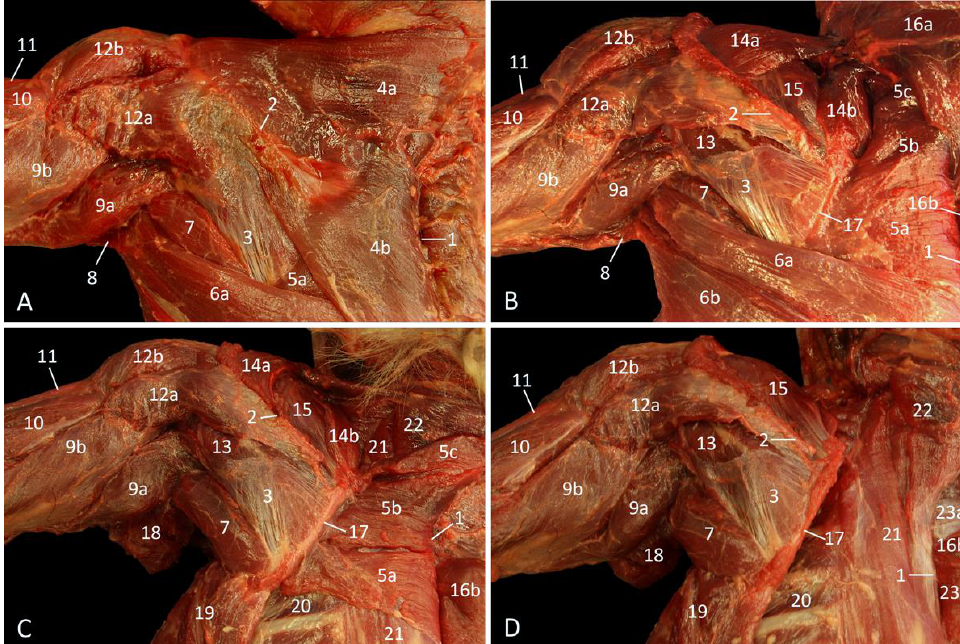
Figure 3. Dorsal view of the left shoulder. ( A ): Superficial layer, ( B ): Second layer, after the m. trapezius has been retracted, ( C ): Deep layer, after removing the m. latissimus dorsi, the m. tensor fasciae antebrachii and the m. trapezius pars cervicalis, ( D ): Deepest layer, after retracting the m. rhomboideus, and the mm. atlantoscapularis cranialis et caudalis.